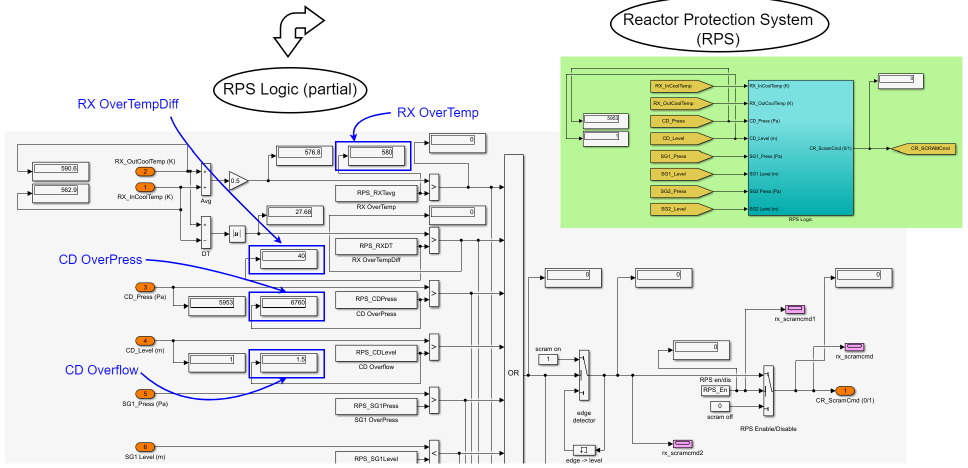
Figure 23. ANS reactor protection system